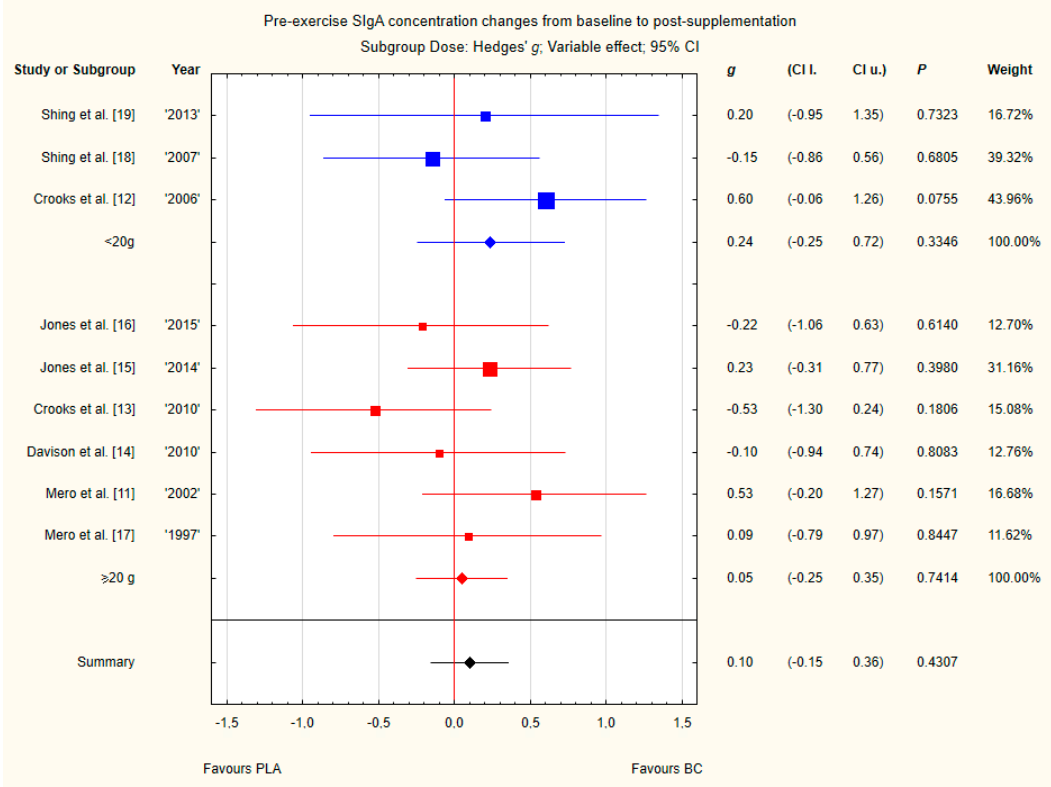
Figure 12. Forest plot of the random-effects meta-analysis of changes from baseline to post-supplementation in pre-exercise SIgA concentration in subgroups regarding BC dose. Test for subgroup differences: Chi 2 = 0.42; df = 1; P = 0.52. Abbreviations: BC–bovine colostrum, SIgA–secretory Immunoglobulin A, PLA–placebo.